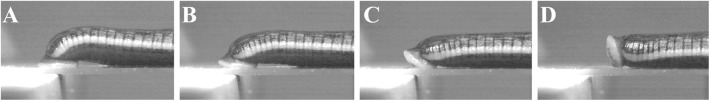
The desorption process of the posterior sucker.A: the suckers contracted starting from the edge and the contact area decreased; B: the edges of the suckers detached from the substrate; C: the sucker bent up; D: the entire detached sucker and body-driven movement.